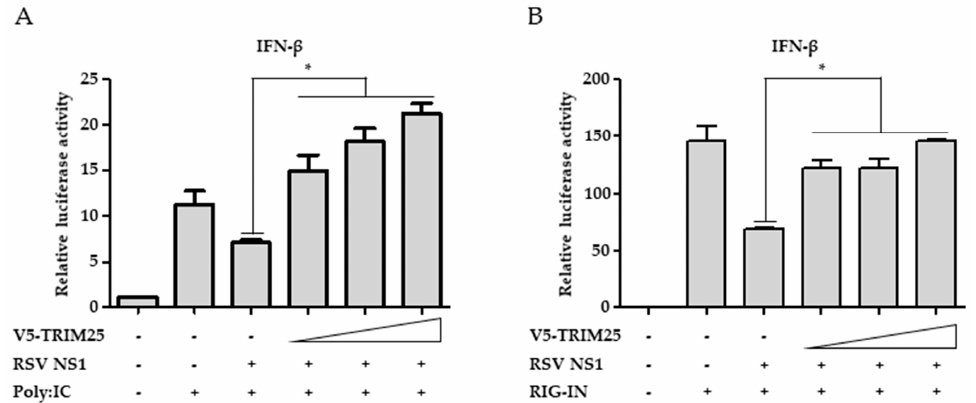
Figure 5. Ablation of interferon- β promoter suppressive effect of NS1 by ectopic expression of TRIM25. ( A , B ) RSV NS1 was expressed with increasing amount of TRIM25 in HEK293T cells. To induce interferon- β promotor activity, low molecular weight polyI:C ( A ) or RIG-IN ( B ) were transfected at the same time as indicated. Interferon (IFN)- β promoter firefly luciferase and Thymidine kinase (TK) renilla luciferase reporter plasmids were co-transfected. Interferon-promoter activities were analyzed by luciferase assays. Data were presented as the mean ± SEM. * p < 0.05. The experiments were repeated at least three times. The results show the most representative data from a single experiment conducted in triplicate.